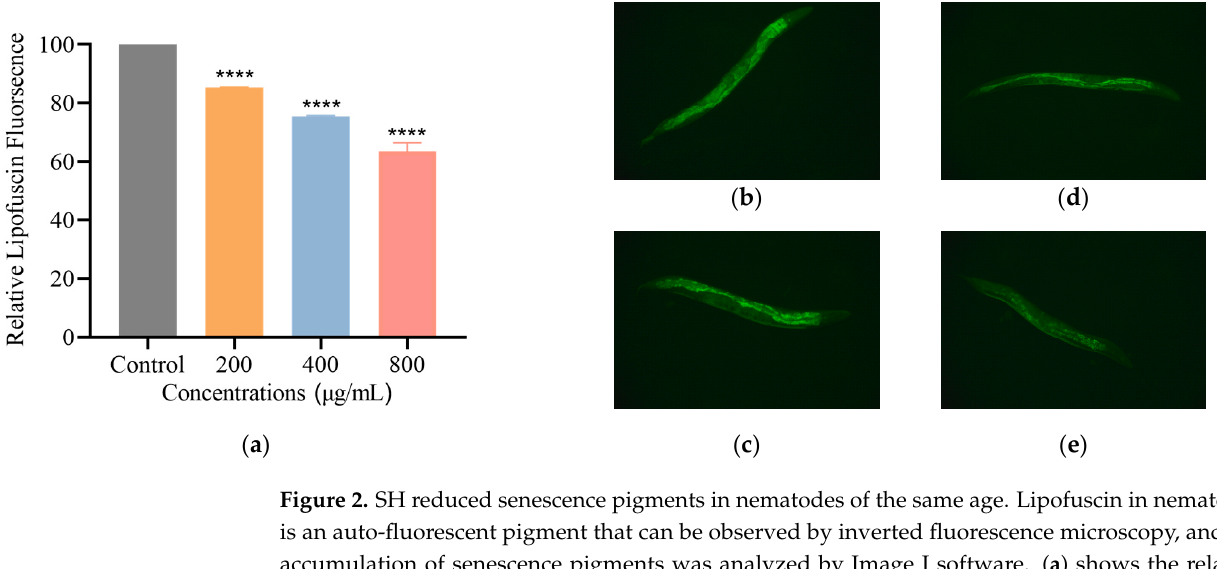
Figure 2. SH reduced senescence pigments in nematodes of the same age. Lipofuscin in nematodes is an auto-fluorescent pigment that can be observed by inverted fluorescence microscopy, and the accumulation of senescence pigments was analyzed by Image J software. ( a ) shows the relative flu- orescence intensity of lipofuscin in each group of nematodes. ( b – e ) show the control group, and the 200 μ g/mL, 400 μ g/mL, 800 μ g/mL SH treatment groups, respectively, as observed under inverted fluorescence microscopy. Lipofuscin assays were carried out in triplicate. Notes: The asterisk (****) represents the significant difference; the larger the number, the more significant.